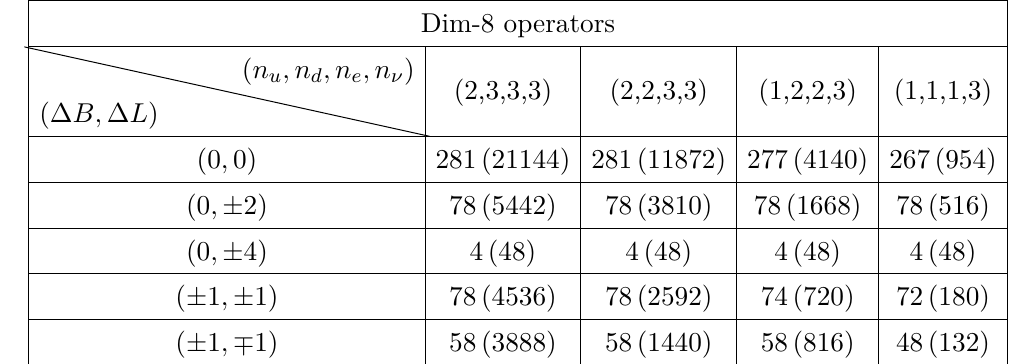
Table 7 . The number of types (operators) of each baryon-number and lepton-number violation pattern with various flavor numbers at dimension 8. n of up-type quarks, down-type quarks, charged leptons and neutrinos respectively. For n n u = 1 , the corresponding active up-type quarks are ( c, u ) and ( u ) respectively, For n d = 3 , 2 , 1 , active down-type quarks are ( b, s, d ) , ( s, d ) and ( d ) respectively, n charged letpons ( τ, µ, e ) , ( µ, e ) and ( e )